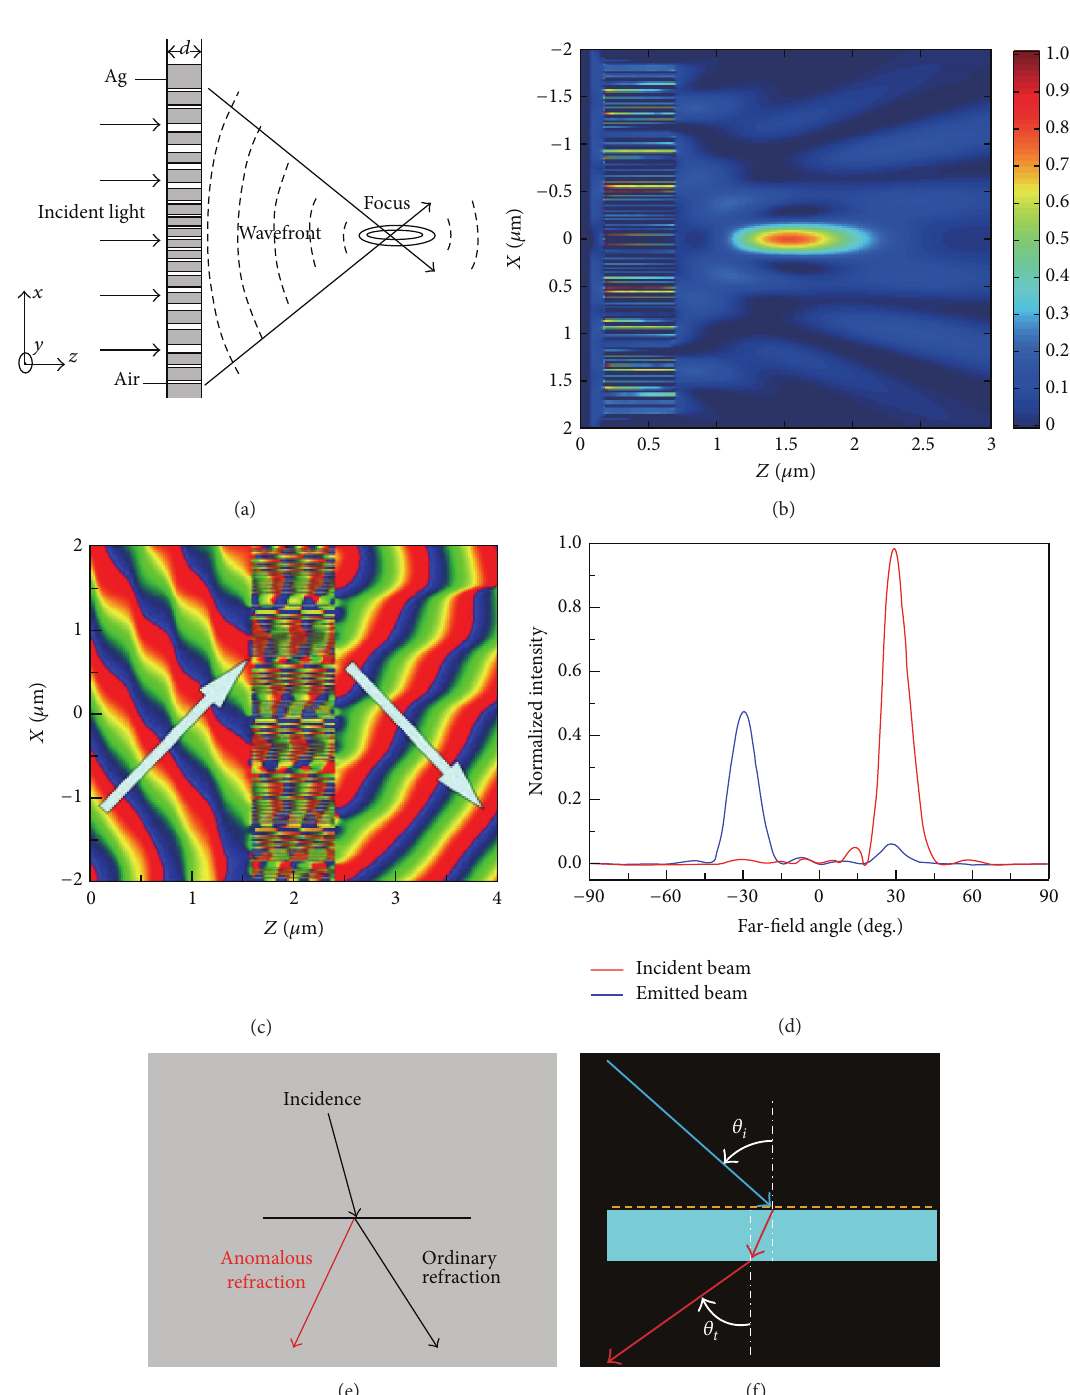
Figure 21: Planar slit array metal lens. (a) Schematic configuration of light focusing of planar metal nanoslit array lens. (b) Normalized Poynting Vector for light focusing of metallic nanoslits lens. (c) Calculated phase distribution of electric field for the designed deflector. Incident and deflection angles are designed as 30 ∘ and − 30 ∘ , respectively. (d) Far-field angular spectrum for the incident and emitted beams, respectively. (e, f) Schematic of the abnormal refraction in other metasurfaces. Figures are reproduced from (a)–(d) [137], (e) [134], and (f)